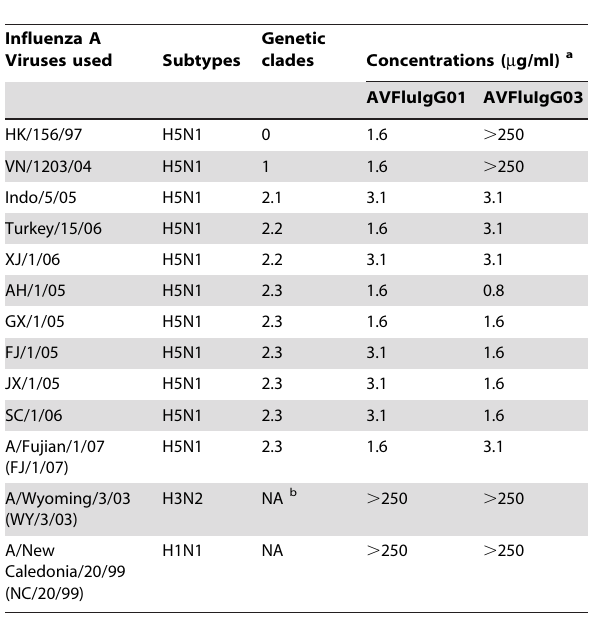
Table 4. HI activity of recombinant human antibodies against influenza A H5N1, H3N2, and H1N1 viruses Influenza A Viruses used